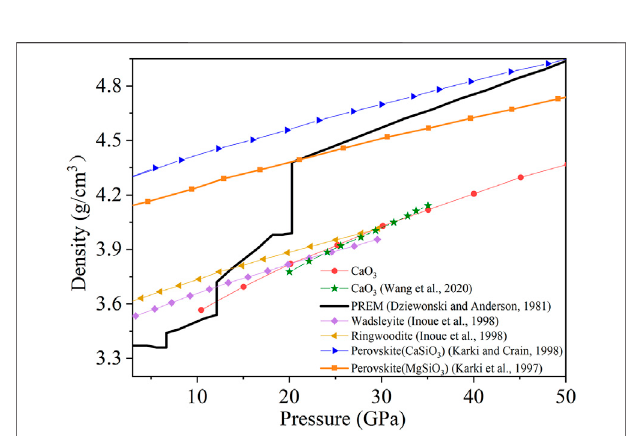
FIGURE 4 | Density of CaO 3 and some selected phases for comparison under 3 – 50 GPa. The red circles represent CaO 3 , the green stars represent the previous data of CaO 3 , the black thick solid line represents the PREM model, the purple diamonds represent wadsleyite, the yellow left triangles represent ringwoodite, the blue right triangles represent perovskite (CaSiO 3 ), and the orange squares represent perovskite (MgSiO 3 ).